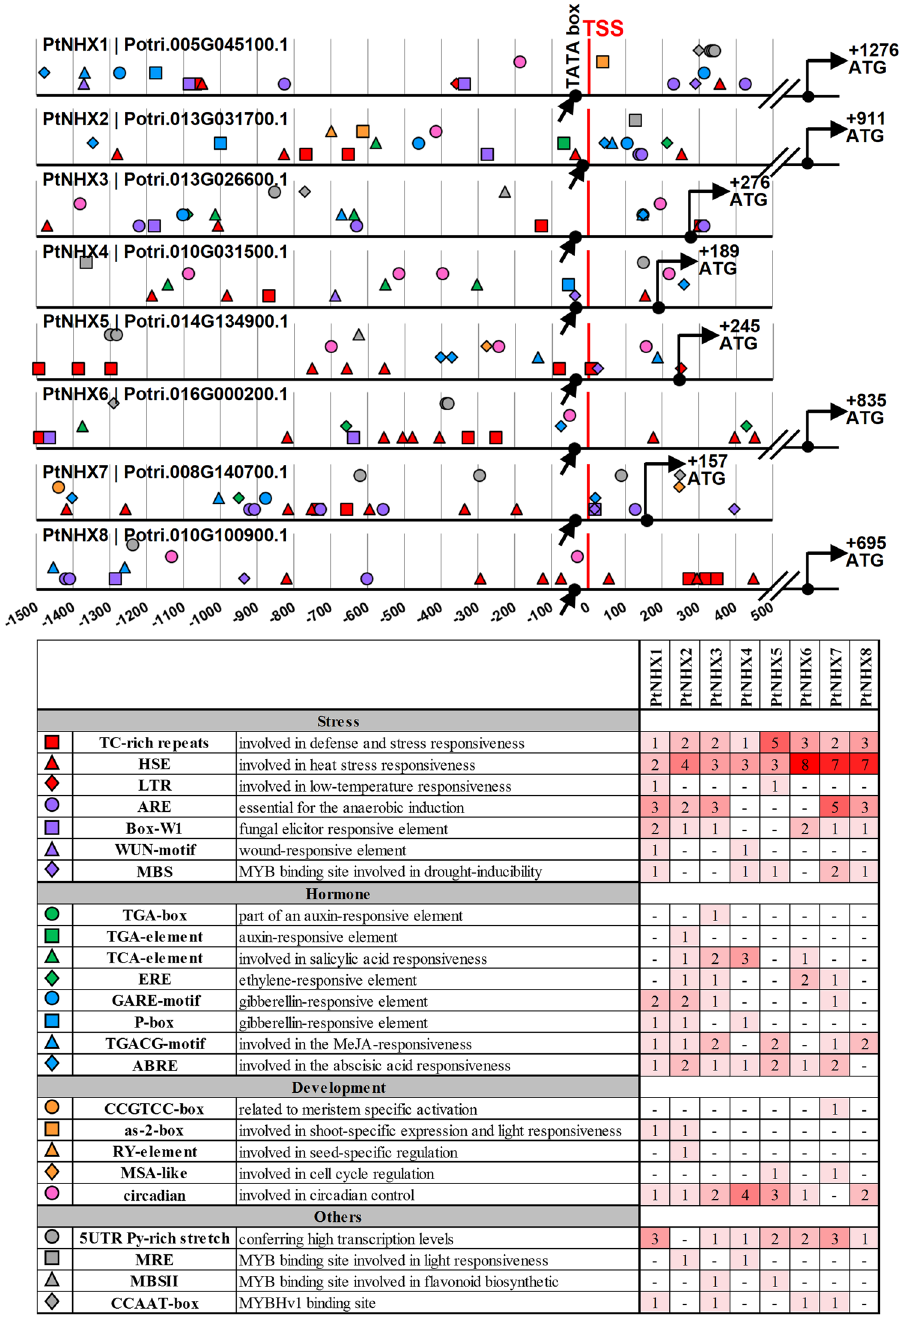
Figure 5. cis -acting elements in PtNHX promoters. Schematic representation of promoter regions of eight PtNHXs . Distances are relative to the transcription start site